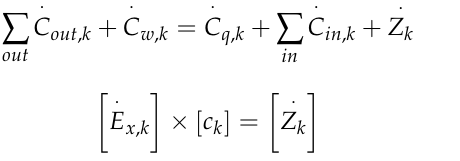
Table 2. Exergy balance equation and supplementary equation of each component in the